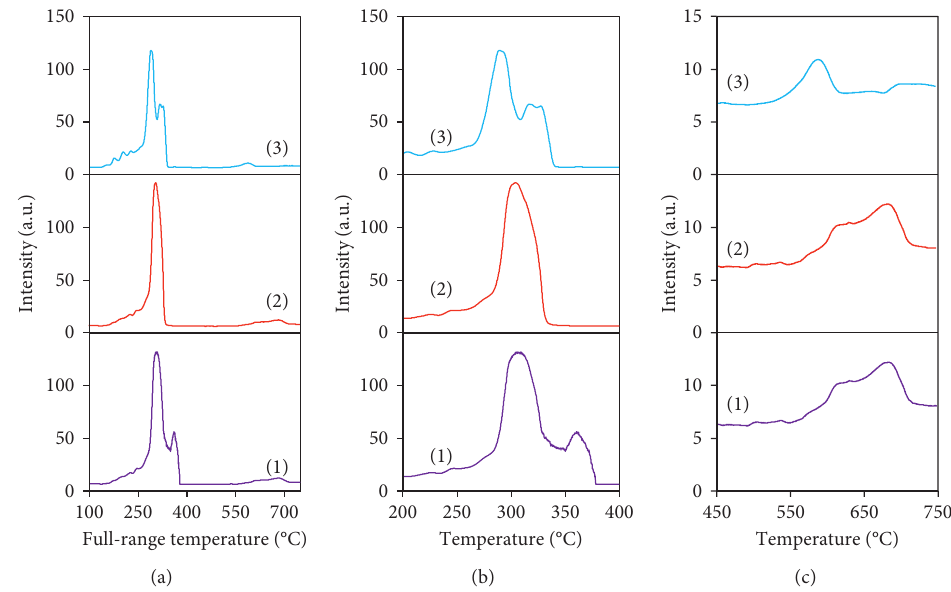
Figure 5: FTIR patterns of OMS-2, CuO/OMS-2, CuMnO 400–500cm − 1 .